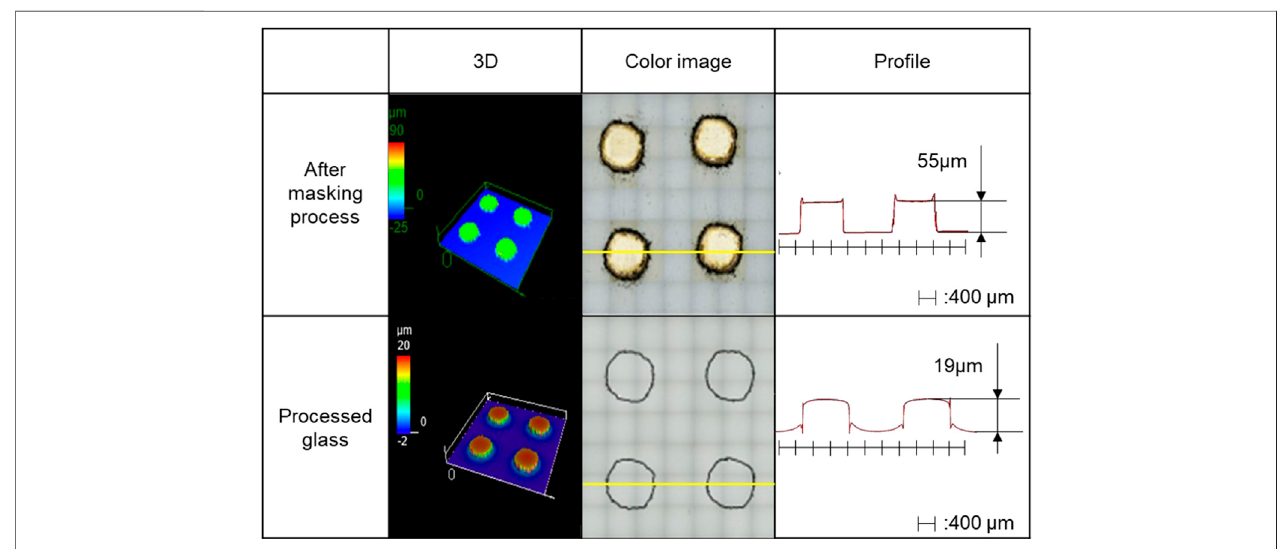
FIGURE 8 | 3D map, color image, and pro fi le of the mask created on the glass surface and glass surface after repeating the MSJ process.